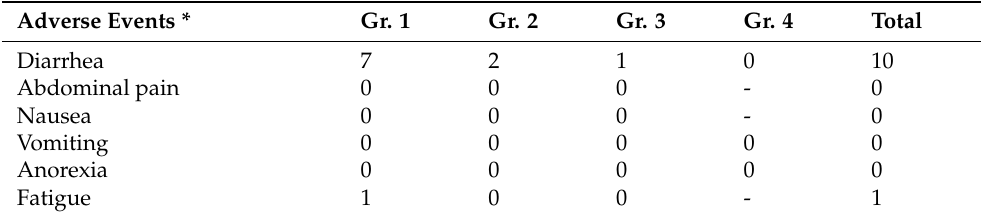
Table 4. Toxicities during naldemedine treatment.